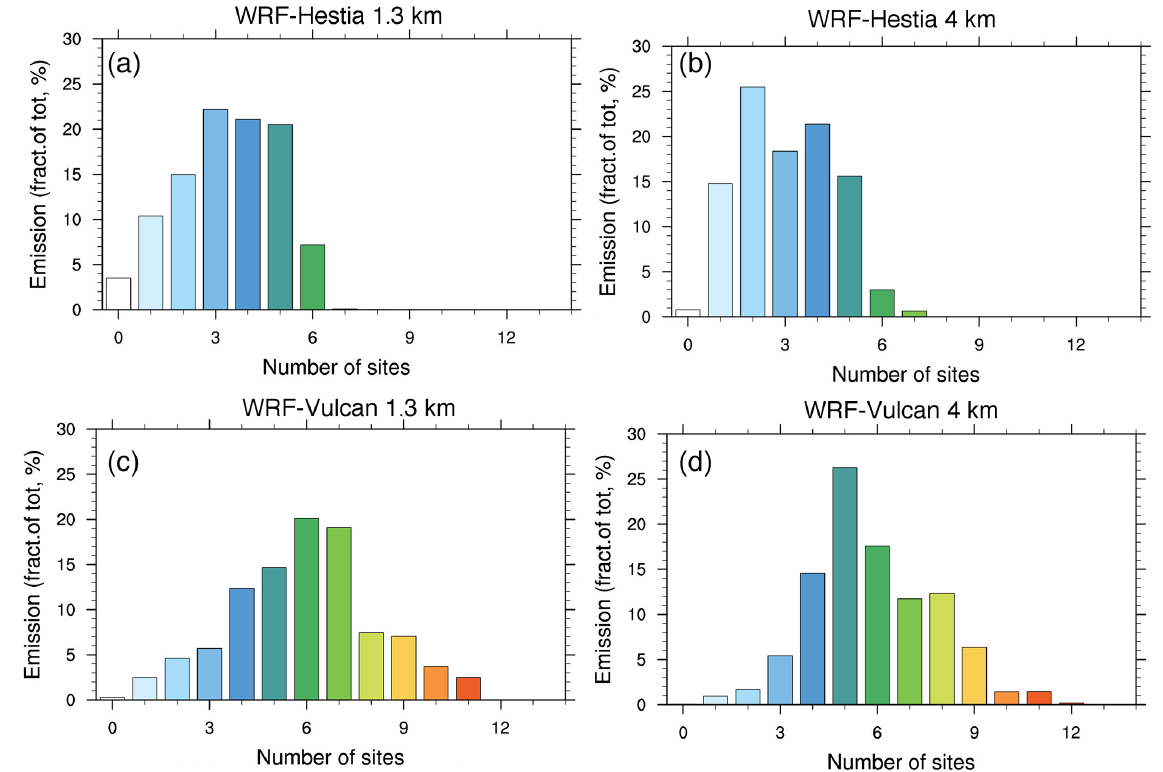
Figure 15. The fraction of the FFCO 2 emission over the LA megacity as function of the number of the GHG measurement sites that covers the area (see Fig. 14) for (a) 1.3km WRF-Hestia, (b) 4km WRF-Hestia, (c) 1.3km WRF-Vulcan, and (d) 4km WRF-Vulcan runs during CalNex-LA. Colour scale is the same as in Fig.